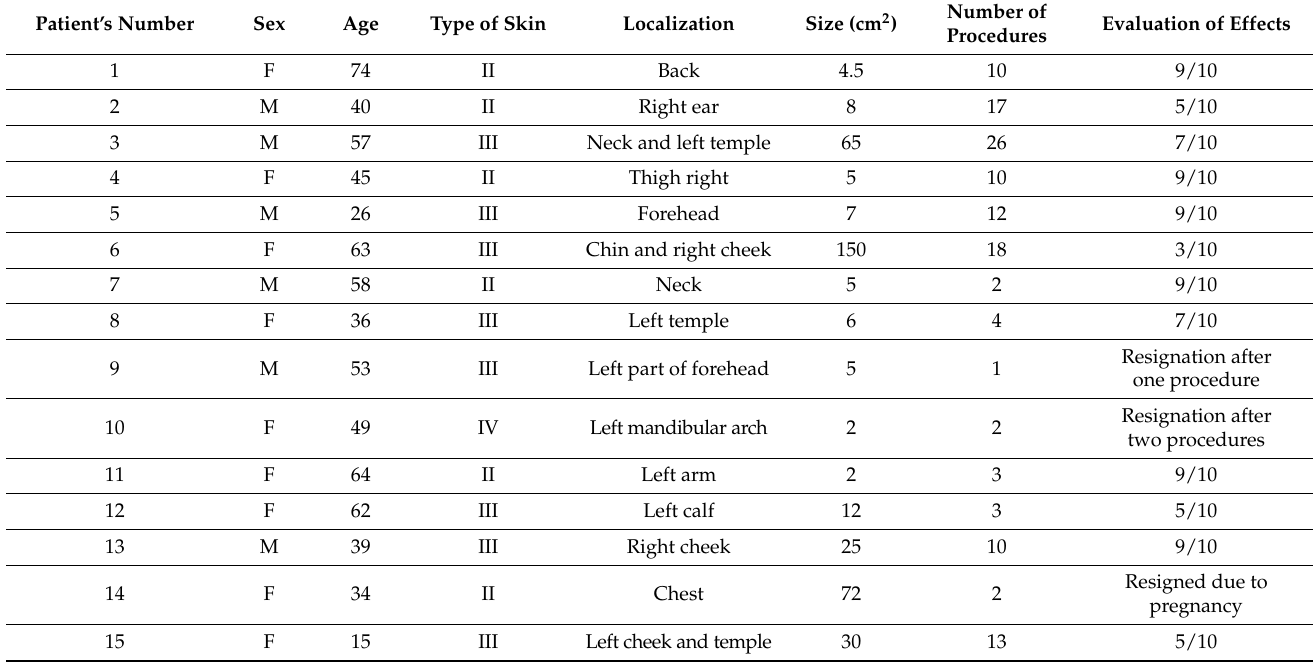
Table 1. Data for the patients with red port wine stains